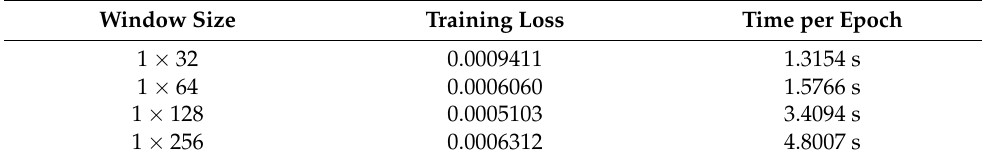
Table 3. The training loss and the training time for different window sizes. Window